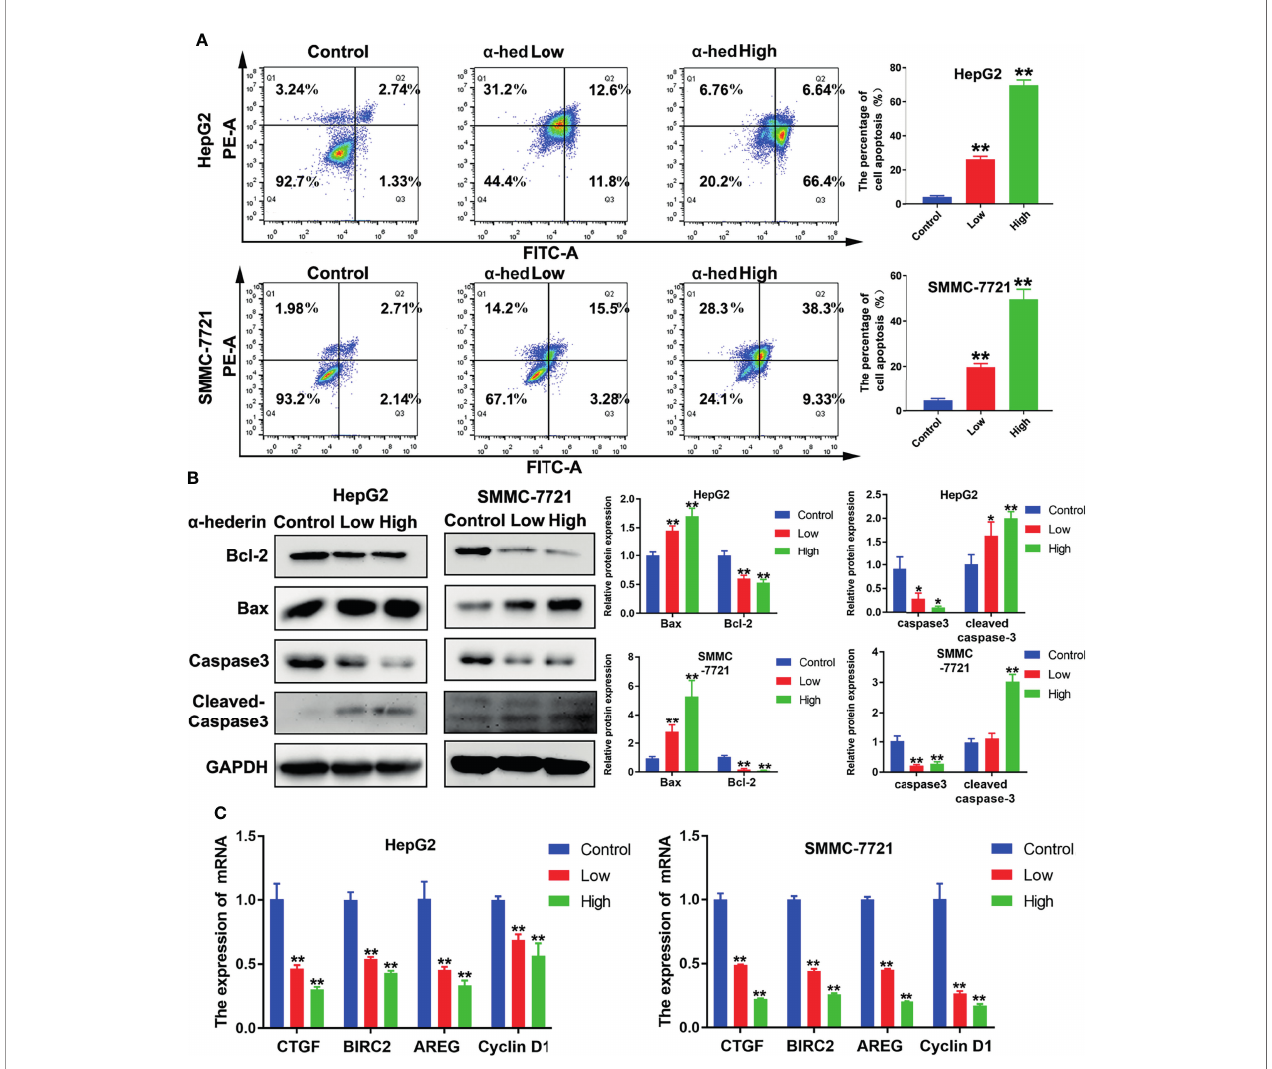
FIGURE 2 | a -hederin promoted apoptosis of HCC cell lines in vitro . (A) Analysis of apoptosis in HepG2 and SMMC-7721 cells treated with a -hederin for 24 hours by fl ow cytometry. (B) The protein levels of Bax, Bcl-2, caspase 3, and cleaved caspase 3 were detected by Western blot in HepG2 and SMMC-7721 cells treated with the indicated concentrations of a -hederin for 24 hours. (C) Analysis of genes associated with cell proliferation and apoptosis in HepG2 and SMMC-7721 cells treated with a -hederin for 24 hours. Signi fi cance: * p < 0.05; ** p < 0.01 versus